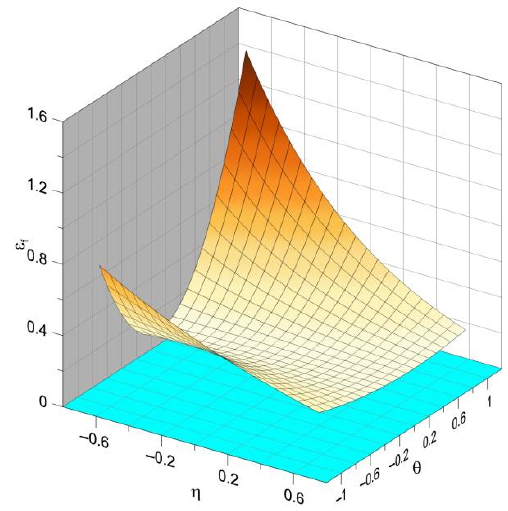
Figure 3. Exemplary fracture locus (source: own simulations).